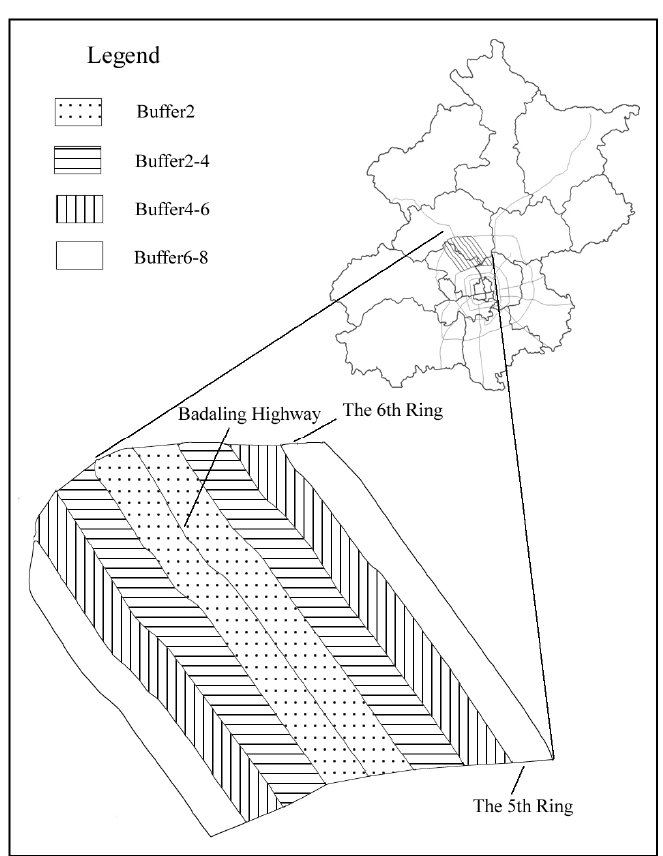
Figure 6. The Study Area (Buffered Belts) along Badaling Highway.